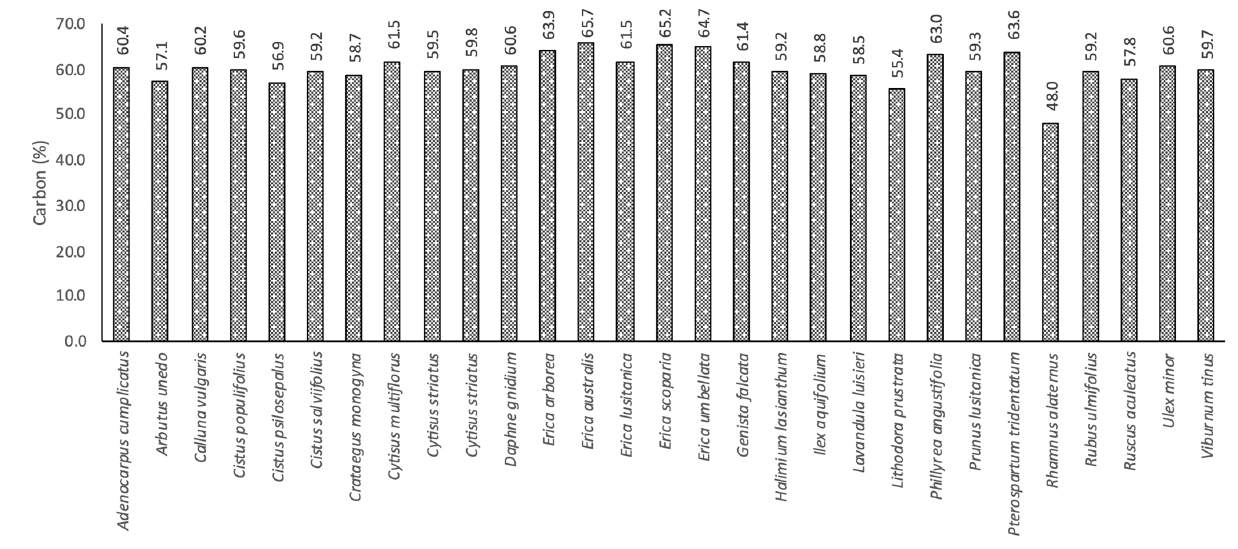
Figure 6. Carbon content (%) of the studied species.